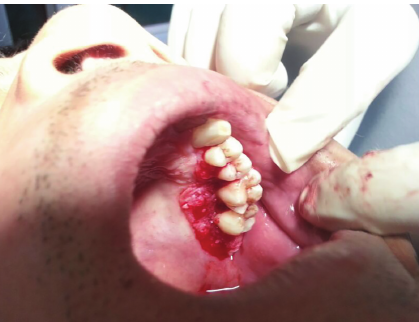
Figure 2: Gingival hyperplasia on left side of mandibular arch.